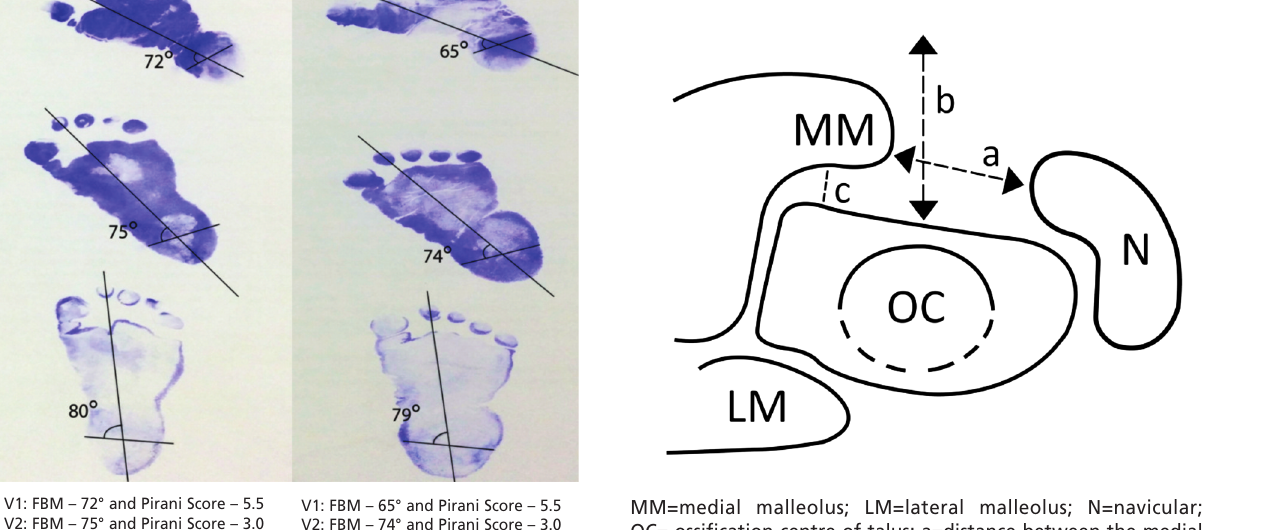
Foot bimalleolar angle (FBM) at initial visit, second visit Fig. 1: and final visit along the course of treatment.